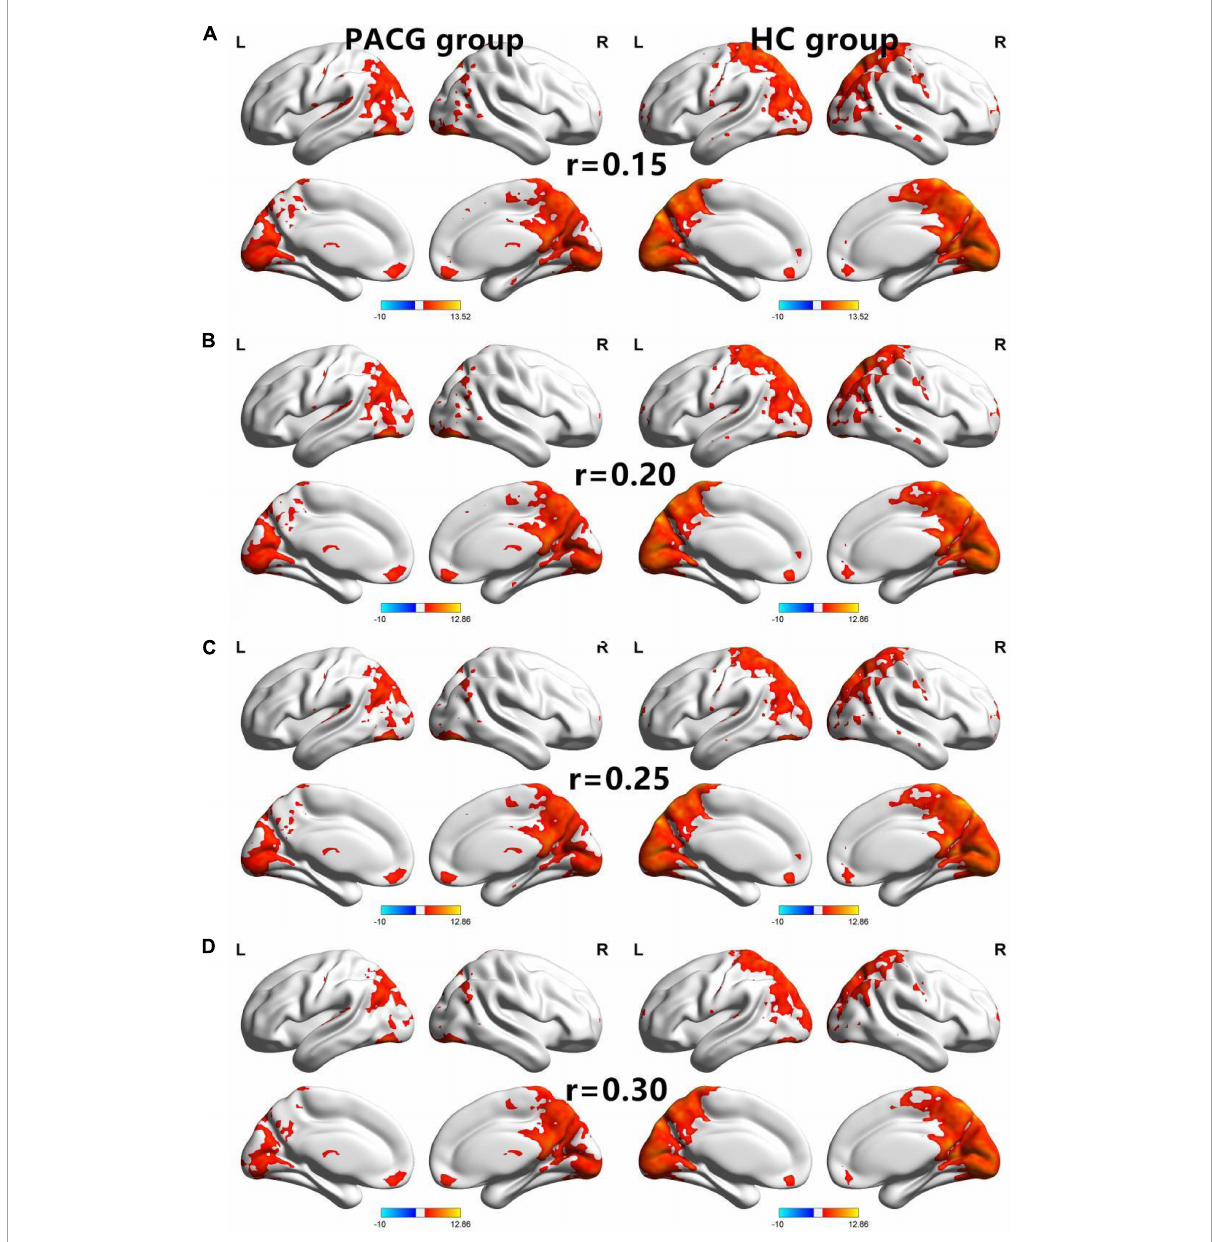
FIGURE1 The spatial of the DC within the PACG and HC with different correlation thresholds ( r = 0.15, 0.2, 0.25, 0.3). The group means DC maps of the PACG and HC [ (A) ( r = 0.15), (B) ( r = 0.20), (C) ( r = 0.25), and (D) ( r = 0.30)]. PACG patients showed remarkably similar altered degree of centrality brain areas relative to healthy control in the different correlation thresholds ( r = 0.15, 0.2, 0.25, 0.3) (FDR correction p < 0.001). DC, degree centrality; PACG, primary angle-closure glaucoma; HC, health control; L, left hemisphere; R, right